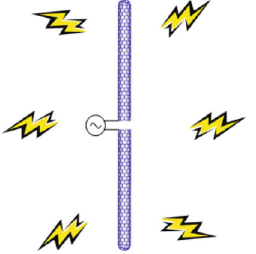
Figure 4: Carbon nanotube as dipole